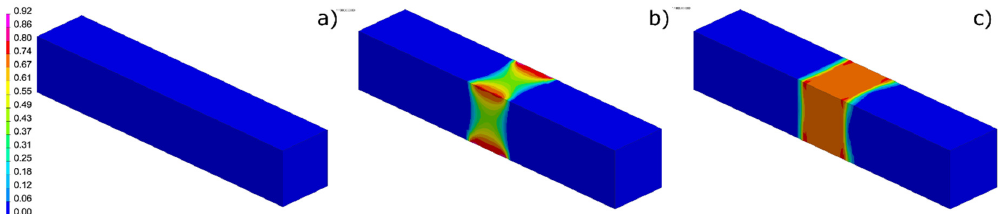
Figure 10. The calculated bainite distributions for a thermal cycle with a maximum temperature of: ( a ) 400 °C, ( b ) 900 °C, and ( c ) 1200 °C (Table 6).